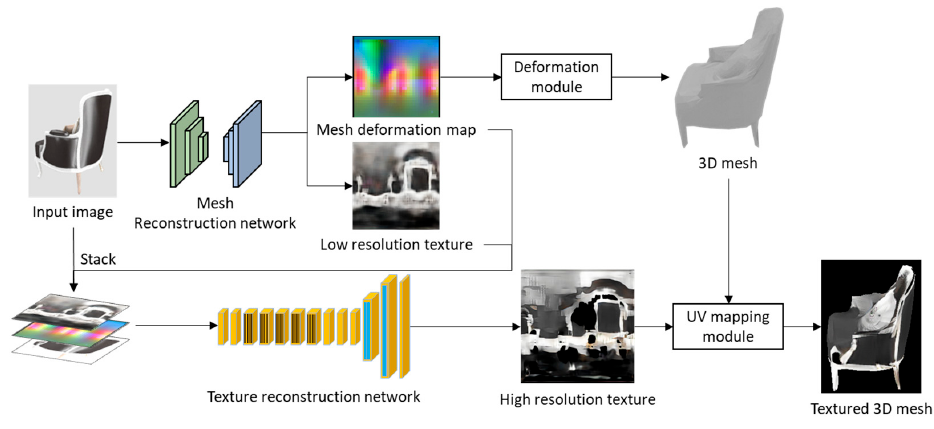
Figure 1. Textured mesh reconstruction workflow.